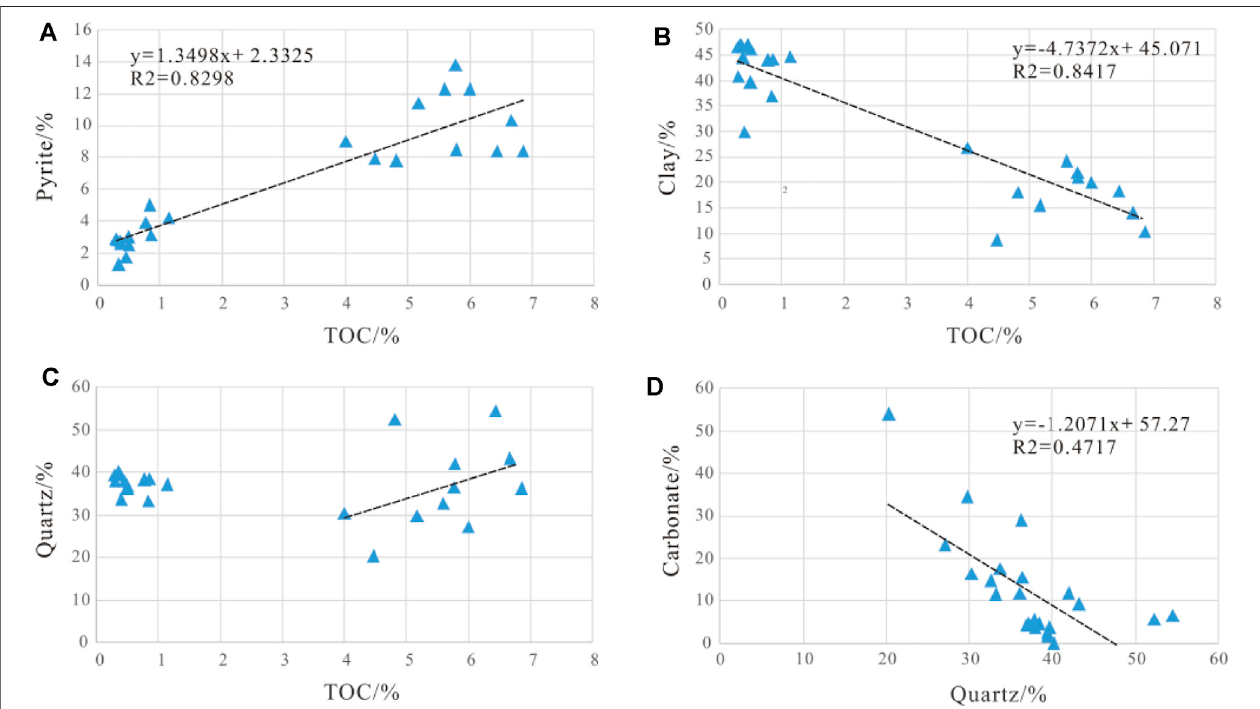
FIGURE 12 | Relationships between mineral contents and TOC of Niutitang shale. (A) Total content of pyrite shows a good positive correlation with TOC; (B) the clay mineral content is negatively related to TOC; (C) the quartz content for shallow continental shelf facies is stable and for deep continental shelf facies the quartz content has a positive correlation with TOC; (D) the contents of quartz and carbonate show an obvious negative correlation.